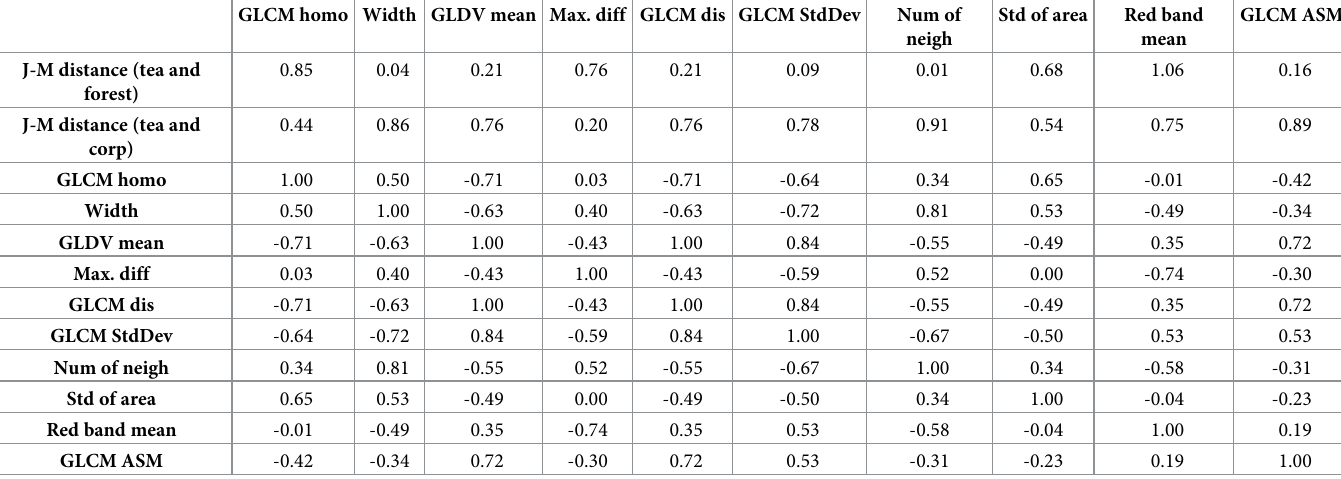
where x l refers to the i-th feature of the l-th sample and x i feature. Features with high correlation coefficients and relatively low J-M distances were removed from the 20 features with the highest J-M distances. The remaining features established a fea- ture set with ten features (Table 4). Table 4. Correlation coefficients and J-M distances of feature set (homo(homogeneity) dis(dissimilarity),